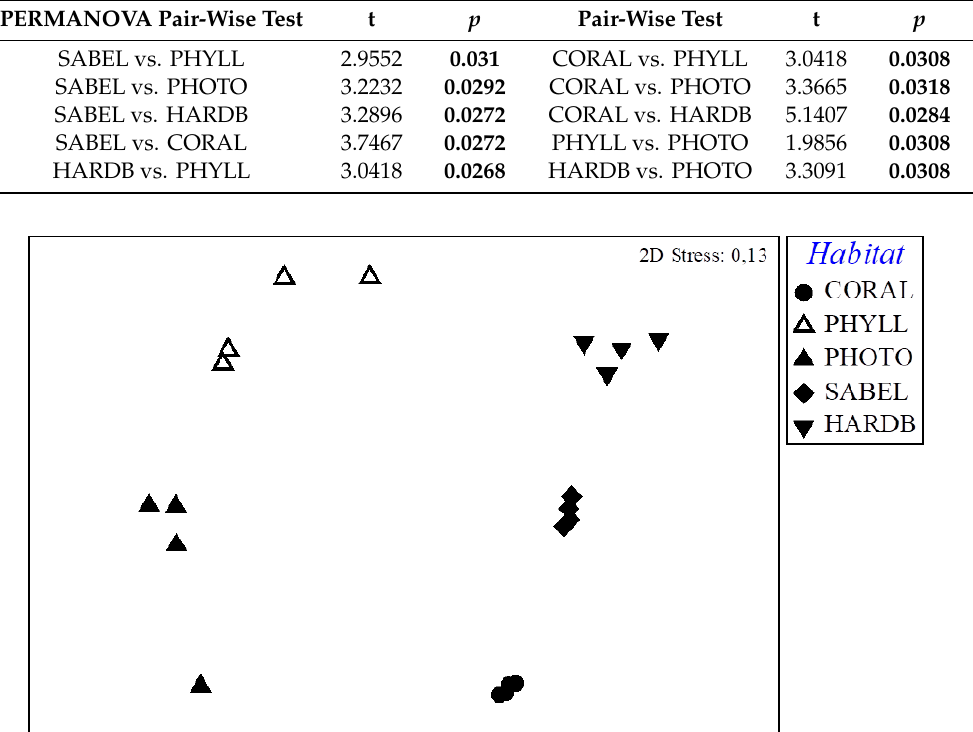
Figure 4. Nonmetric multidimensional scaling (nMDS) plot of molluscan assemblage, based on Bray-Curtis similarity matrix, of all replicates for each habitat.